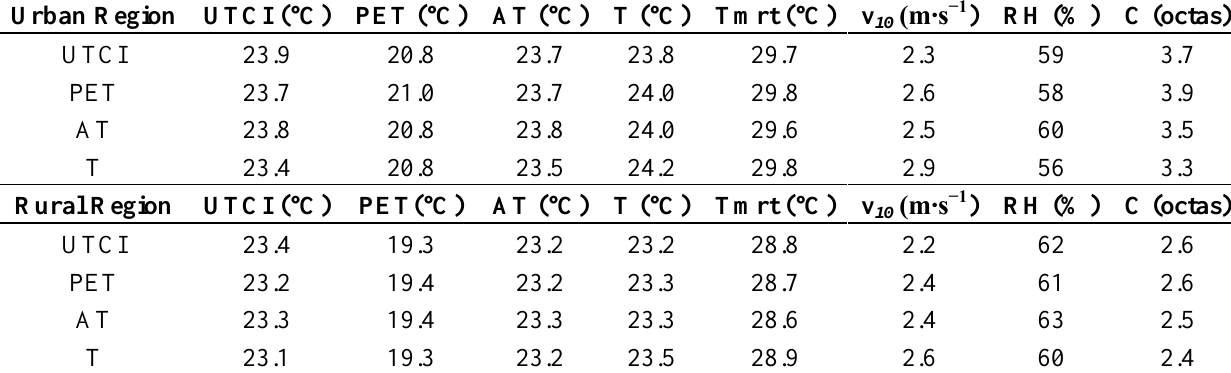
Table 4. Average values of (equivalent) temperature indices and input meteorological variables on warm days identified by individual indices in urban vs . rural